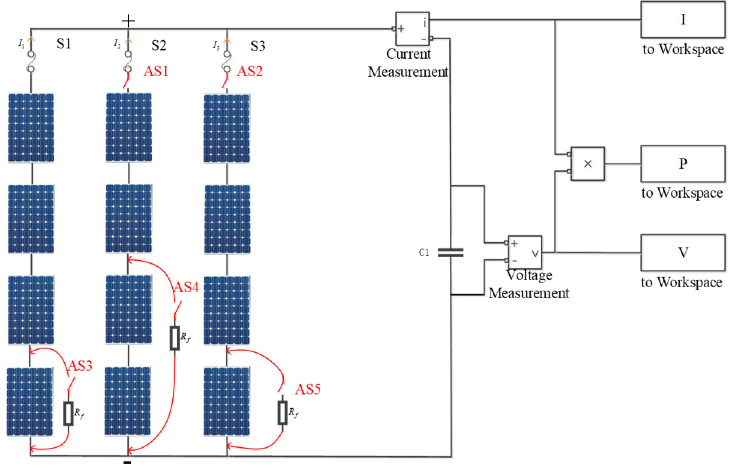
Figure 2. The simulation model of 4 × 3 PV array.